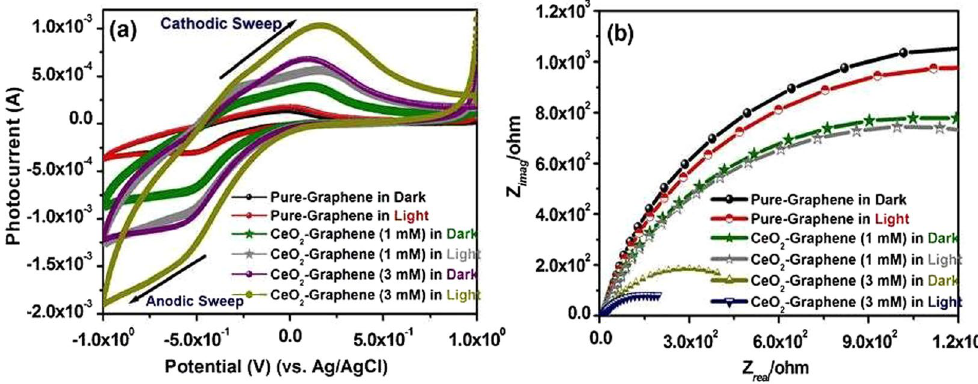
Figure 10. ( a ) Cyclic voltammetry profile, and ( b ) EIS Nyquist plot for the pure-graphene and CeO 2 -Graphene nanostructures in a 0.1 M phosphate buffer electrolyte solution at 25 °C with a scan rate of 0.05